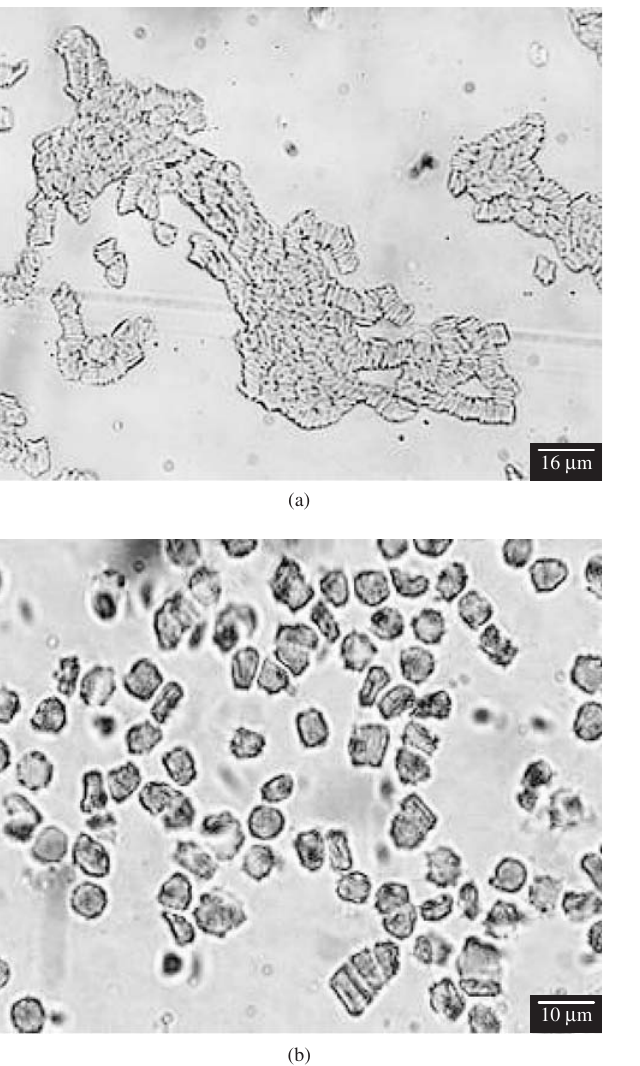
Figure 4. a) Microstructure of pig blood; and b) Microstructure of pig blood containing 50% (v/v) of T. infestans saliva